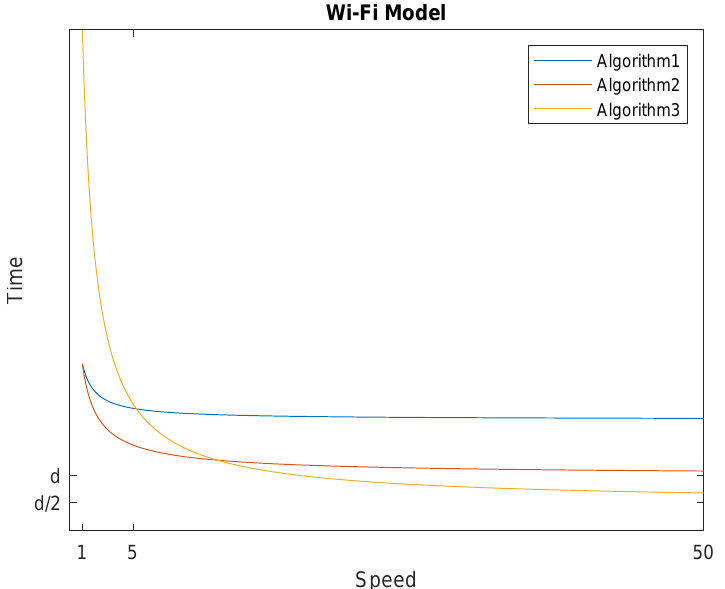
Figure 1. Graph for the three algorithms using the wi-fi model. On high speed, the evacuation time for Algorithm 4 converges to d versus 2 d and d for Algorithms 2 and 3, 2